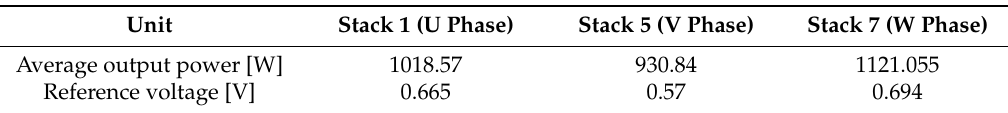
Table 2. Comparison of RMS values of average output power and reference voltage when fourth stack fails in applying the conventional neutral-point voltage-shifting control.